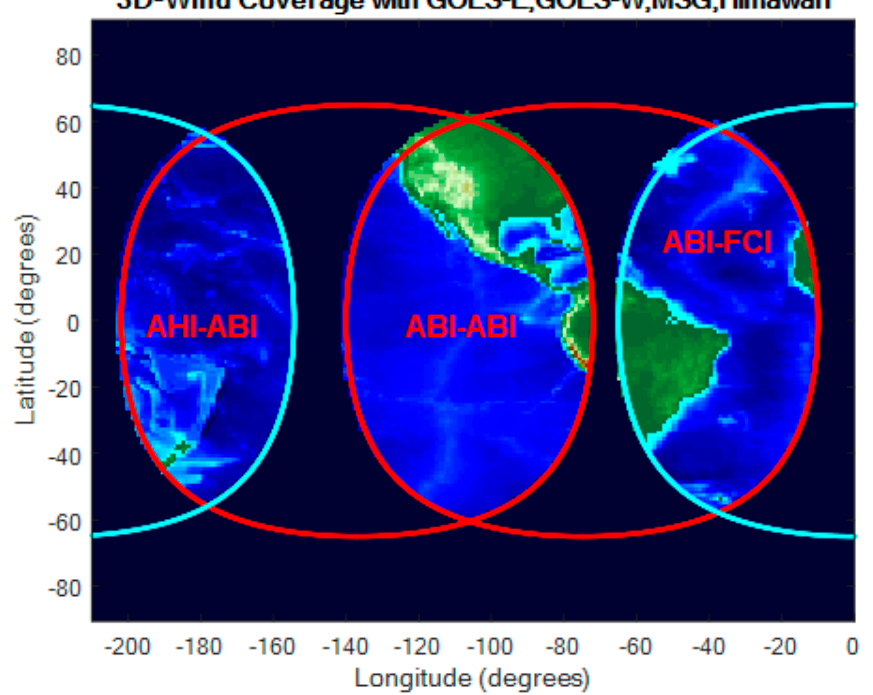
Figure 1. Geostationary (GEO)-GEO stereo-wind products are possible in the overlaps between the coverage circles of each GEO. The circles drawn are limited to an Earth central angle (ECA) < 65° around the SSP for each of the satellites.